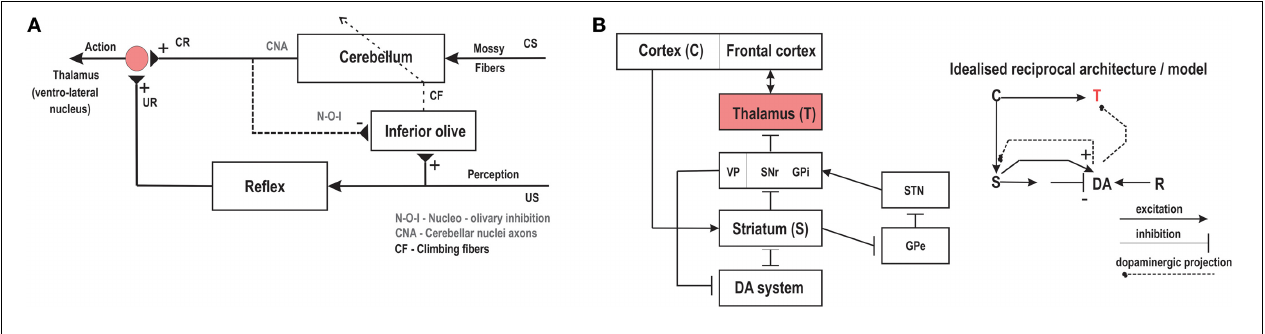
FIGURE 2 | (A) Schema of the cerebellar controller with the reflexive pathways and anatomical projections leading the acquisition of reflexive behaviors. CS, conditioned stimulus; US, unconditioned stimuli; CR, conditioned response; UR, unconditioned response. (B) (right) Schematic representation of the neural architecture of the basal ganglia circuitry